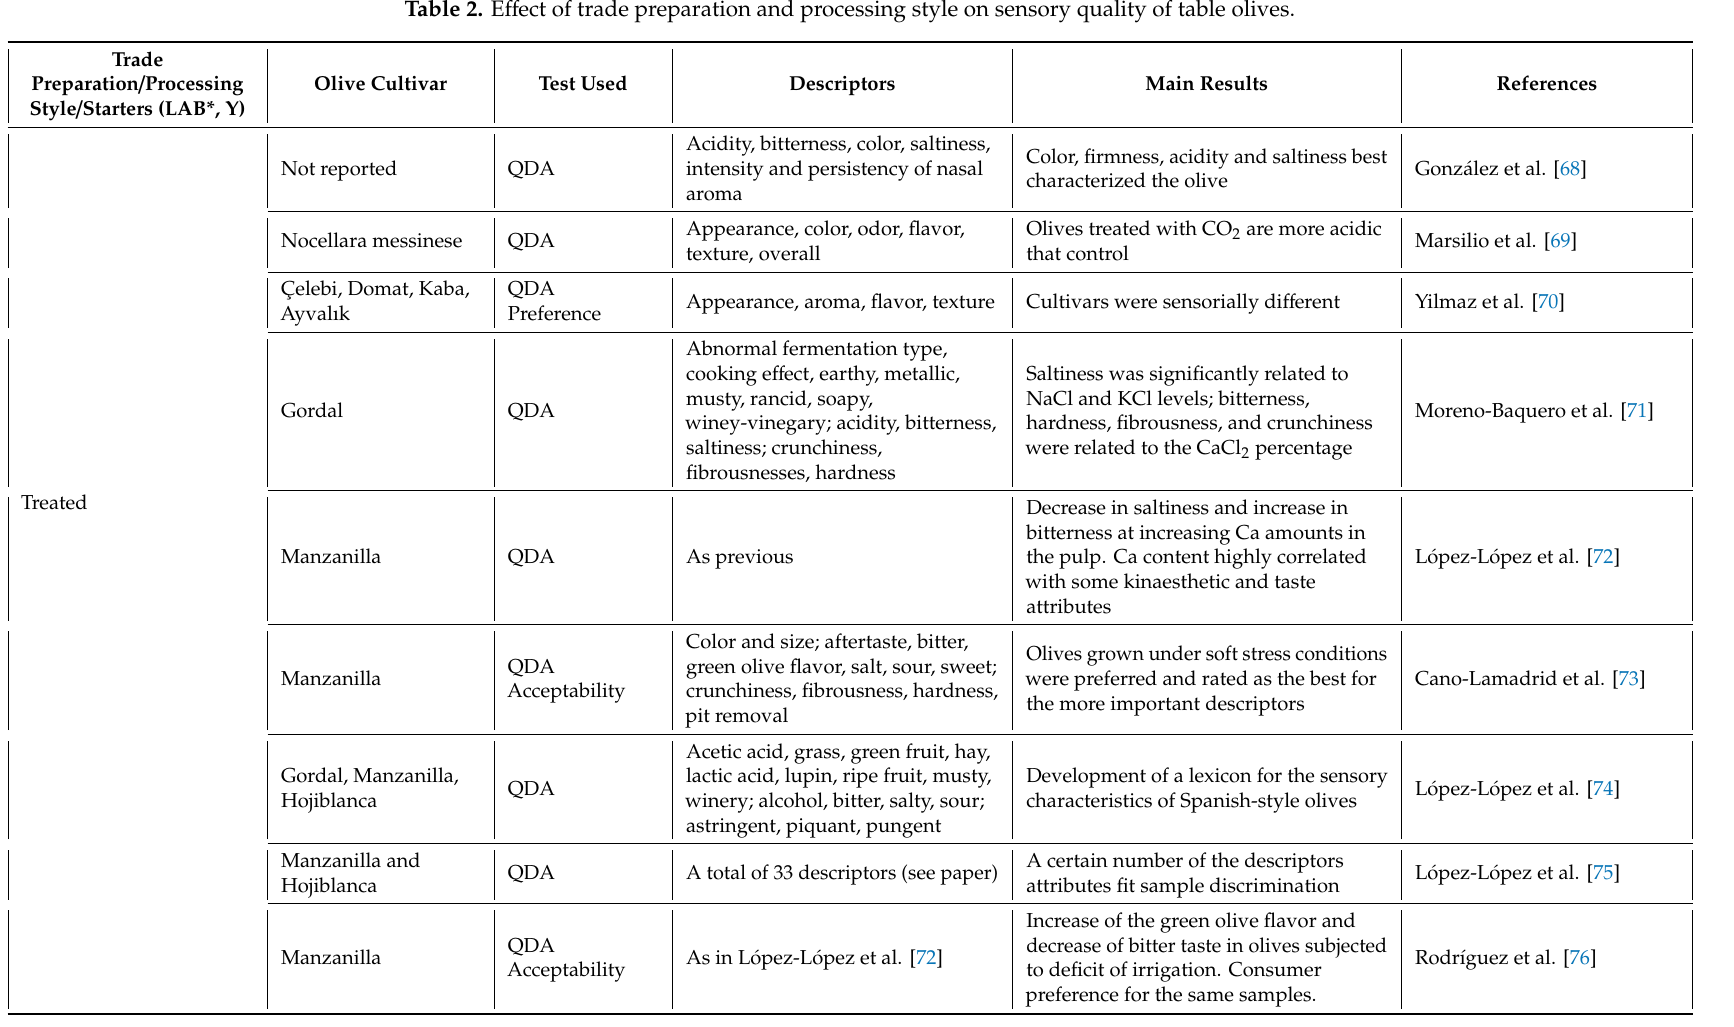
Table 2. E ff ect of trade preparation and processing style on sensory quality of table